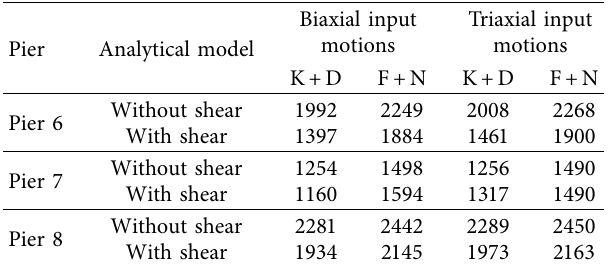
Figure 15: Transverse hysteretic response without and with shear subjected to biaxial input ground motions of multiple earthquakes, F+N. (a) Pier 6. (b) Pier 8. Table 5: Maximum transverse lateral force without and with shear under multiple input ground motions